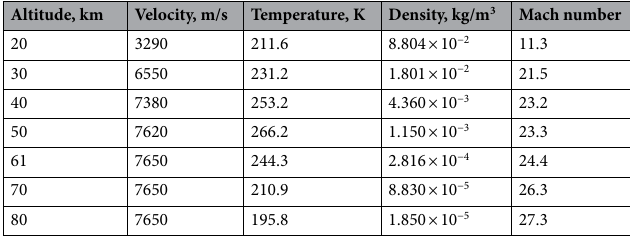
Table 1. Free stream parameters for different reentry heights.